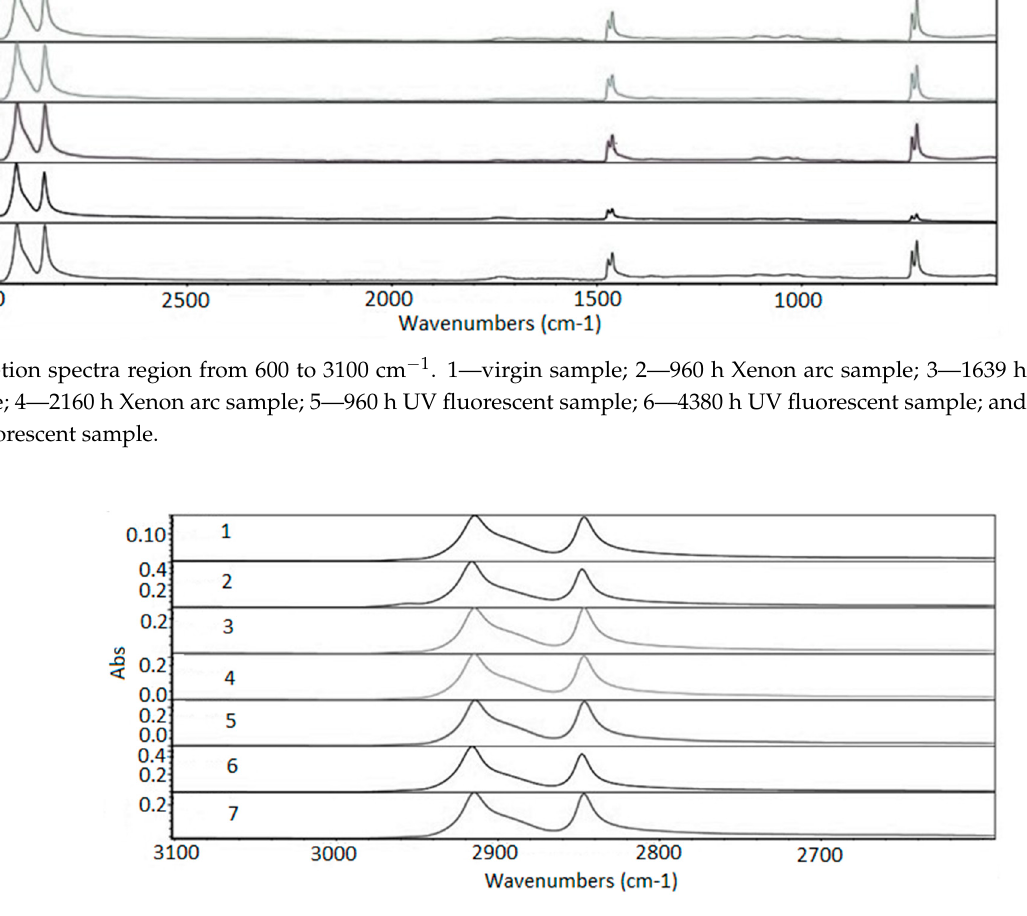
Figure 6. Absorption spectra region from 600 to 3100 cm − 1 . 1—virgin sample; 2—960 h Xenon arc sample; 3—1639 h Xenon arc sample; 4—2160 h Xenon arc sample; 5—960 h UV fluorescent sample; 6—4380 h UV fluorescent sample; and 7—8760 h UV fluorescent sample.